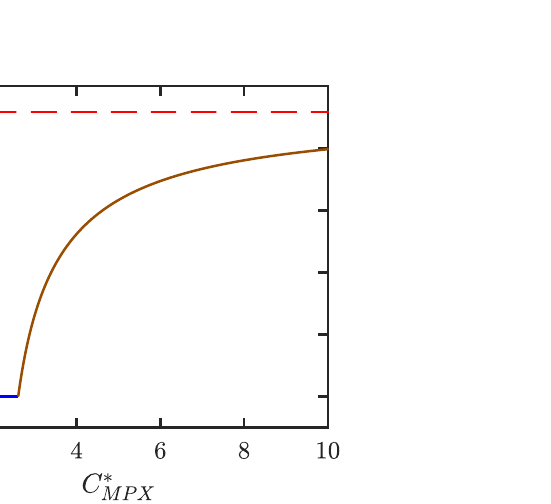
Fig 6. The optimal voluntary vaccination rates. The lines are color coded corresponding to the regions shown in Fig 9 which shows a diagram for Nash equilibria as e and C � vary. Blue: 0 is the only NE and it is CSNE. Brown: positive MPX ψ NE is the only NE and it is CSNE. Red dashed line shows the value of ψ HI . Unless varied or otherwise specified, the parameters are as in Table 1.